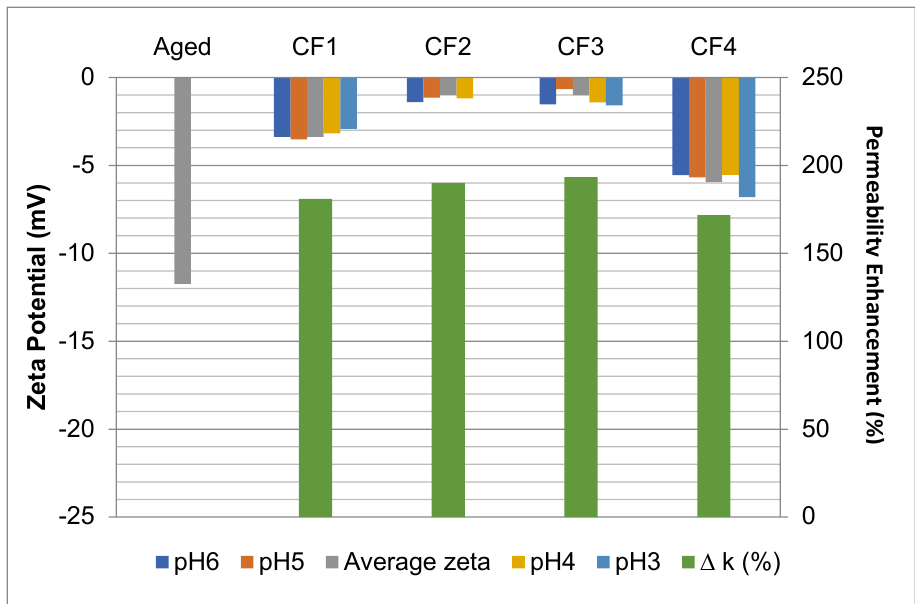
Figure 18. Zeta potential (pH3 to pH6) vs. permeability enhancement (category1).